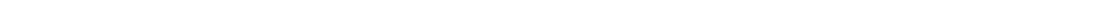
(see fi gure on previous page) Fig. 5 Lipid peroxidation and cell deaths propagated from ferroptotic cells to surrounding cells. A – G After WT MEFs had been exposed to erastin, the supernatant medium was exchanged (erastin was removed). At that time, Kusabira Orange (KuO) mice-derived MEFs were added. After 9 h from adding KuO MEFs, MEFs were analyzed by a fl uorescent microscope. After 12 h from adding KuO MEFs, MEFs were analyzed by a fl ow cytometer. A Experimental outline. B Optical and fl uorescent microscope image after Liper fl uo staining. White arrowheads: KuO MEFs without lipid peroxidation. Pink arrowheads: WT MEFs with lipid peroxidation. Yellow arrowheads: KuO MEFs with lipid oxidation. C Representative data of the histogram of KuO fl uorescence by fl ow cytometer to distinguish KuO MEFs from WT MEFs. D , F Representative data of the histogram of Liper fl uo fl uorescence in WT MEFs ( D ) or KuO MEFs ( F ) by fl ow cytometer. Values on the upper left and upper right represent, respectively, the percentage of negative and positive cells. The colors correspond to histogram traces. E , G Quanti fi cation of Liper fl uo-positive cells, Liper fl uo MFI, and cell deaths in WT MEFs ( E ) or KuO MEFs ( G ) by fl ow cytometer. H , I Erastin was added to dishes without cells. After 24 h, the supernatant medium was exchanged (erastin was removed). At that time, KuO MEFs were added. After 12 h from adding KuO MEFs, MEFs were analyzed by a fl ow cytometer. H Representative data of the histogram of Liper fl uo fl uorescence in KuO MEFs as above. I Quanti fi cation of Liper fl uo-positive cells, Liper fl uo MFI, and cell deaths in KuO MEFs by fl ow cytometer. Light-green scale bars in B represent 75 µm. Purple scale bars in B represent 50 µm. All data are representative of two independent experiments. Error bars of E , G , and I represent SD. P value of E , G , and I by unpaired two-sided t test. MFI mean fl uorescence intensity.